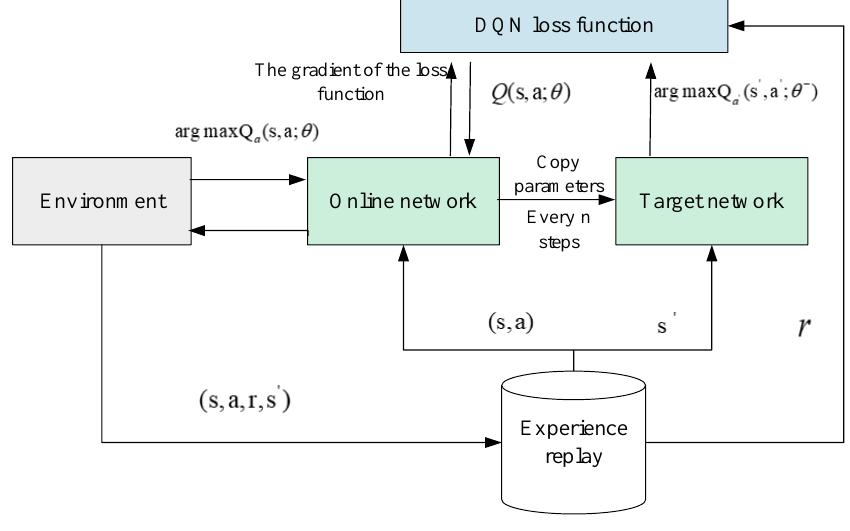
Figure 6. DQN learning process.